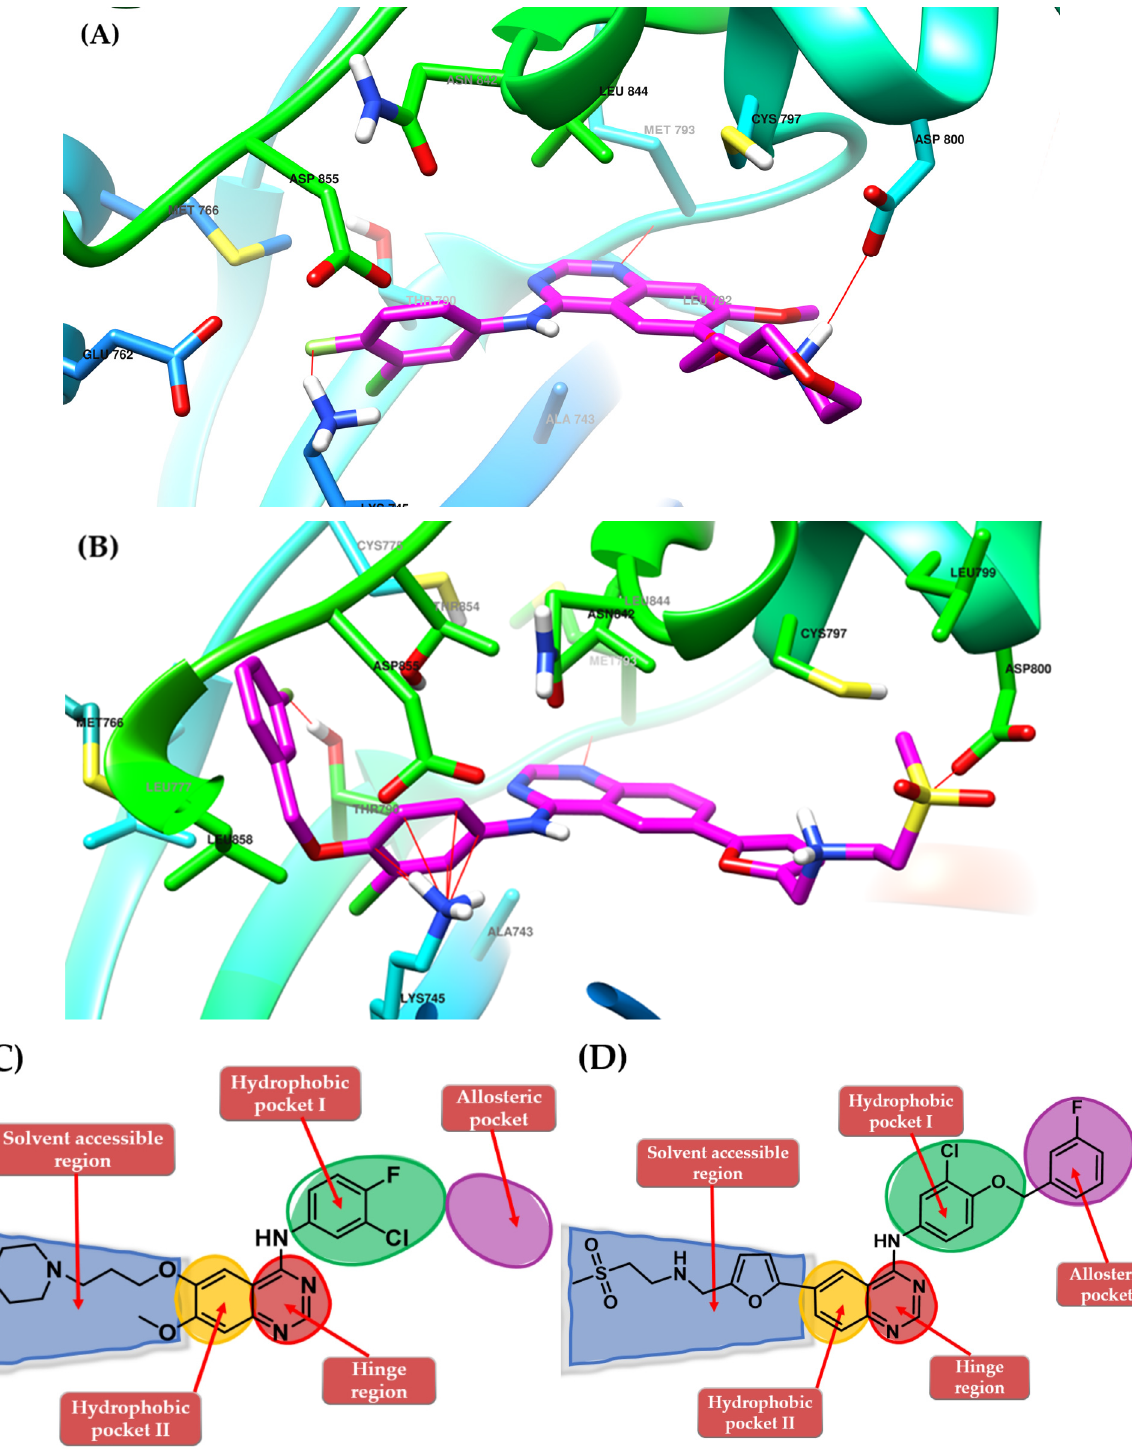
Figure 2. Visualization of gefitinib ( A ) and lapatinib ( B ) binding to the human EGFR kinase domain co-crystallized in the complexes 1XKK [101] and 2ITZ [51], from the Protein Data Bank [102] was performed using Chimera 1.10.2 (University of California, Oakland, CA, USA) [103]; regions of the active site and adjacent regions of the kinase domain occupied by gefitinib ( C ) and lapatinib ( D ).